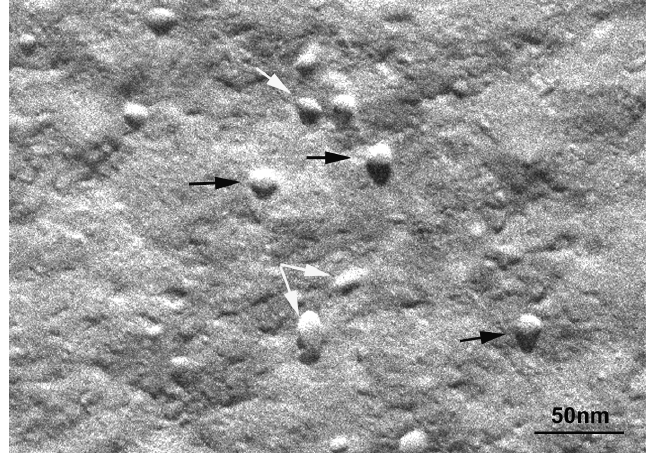
Figure 10. Micrograph of DPPC/DHPC bicelles at 37 °C. The black arrows denote the disks in face-on disposition and the white arrows correspond to the disks in